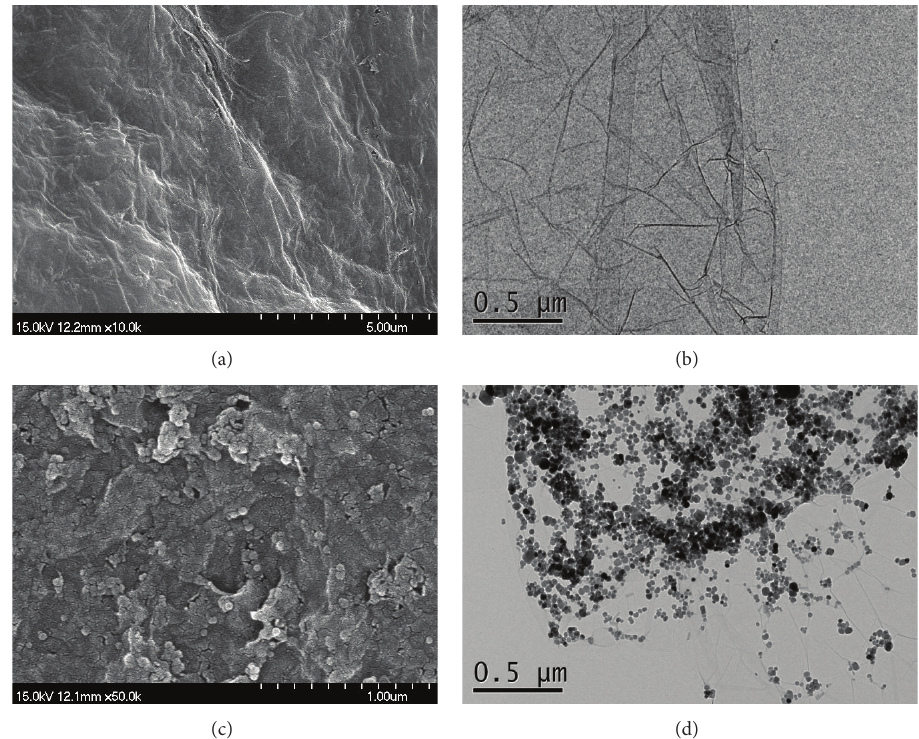
Figure 1: SEM (a) and TEM (b) images of the bare GO for this study. SEM (c) and TEM (d) images of the magnetic GO synthesized in this